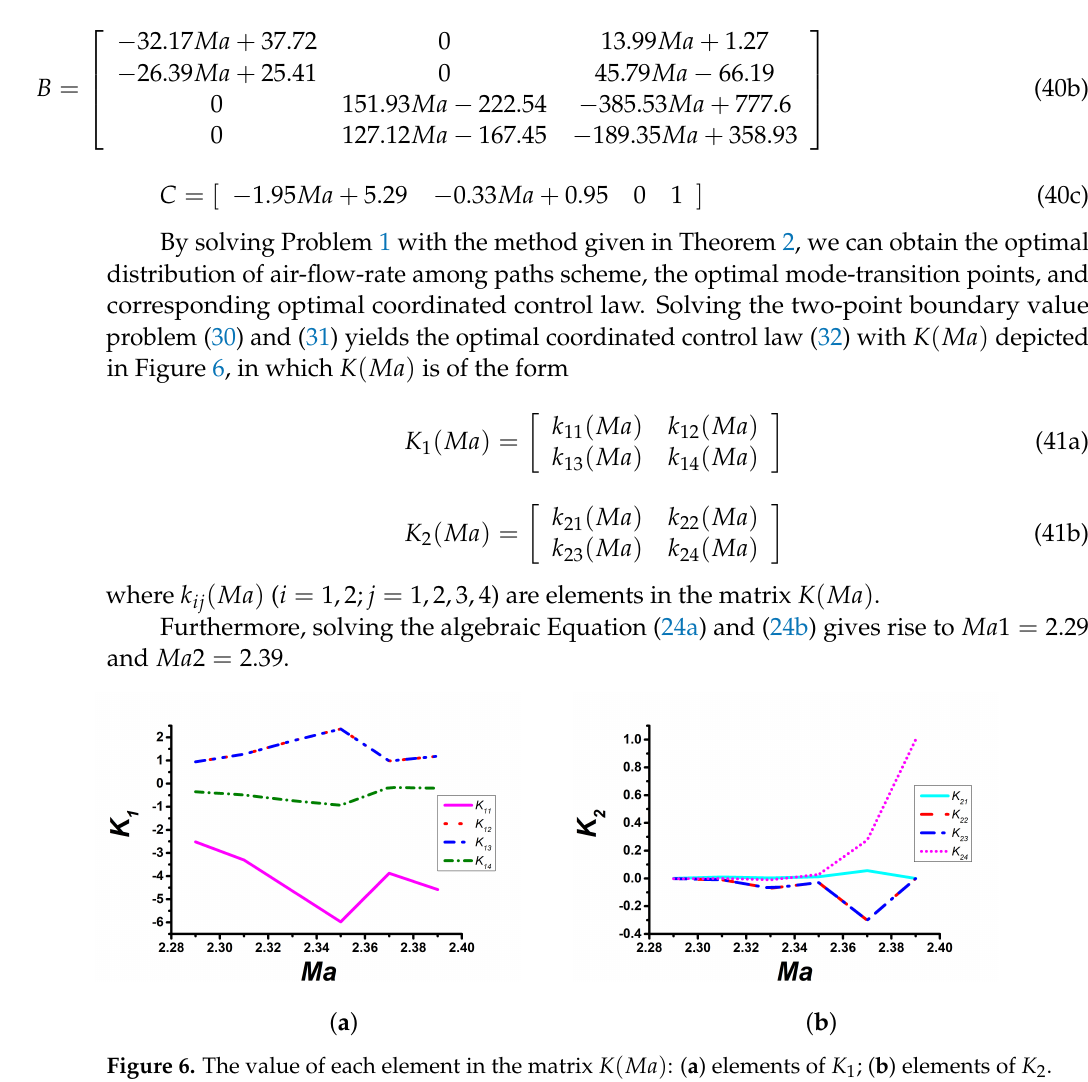
Figure 6. The value of each element in the matrix K ( Ma ) : ( a ) elements of K 1 ; ( b ) elements of K 2 . When making a simulation, the real control law in each channel of XTER is the sum of u e ( Ma ) + ∆ u opt ( Ma ) , which is detailed in the